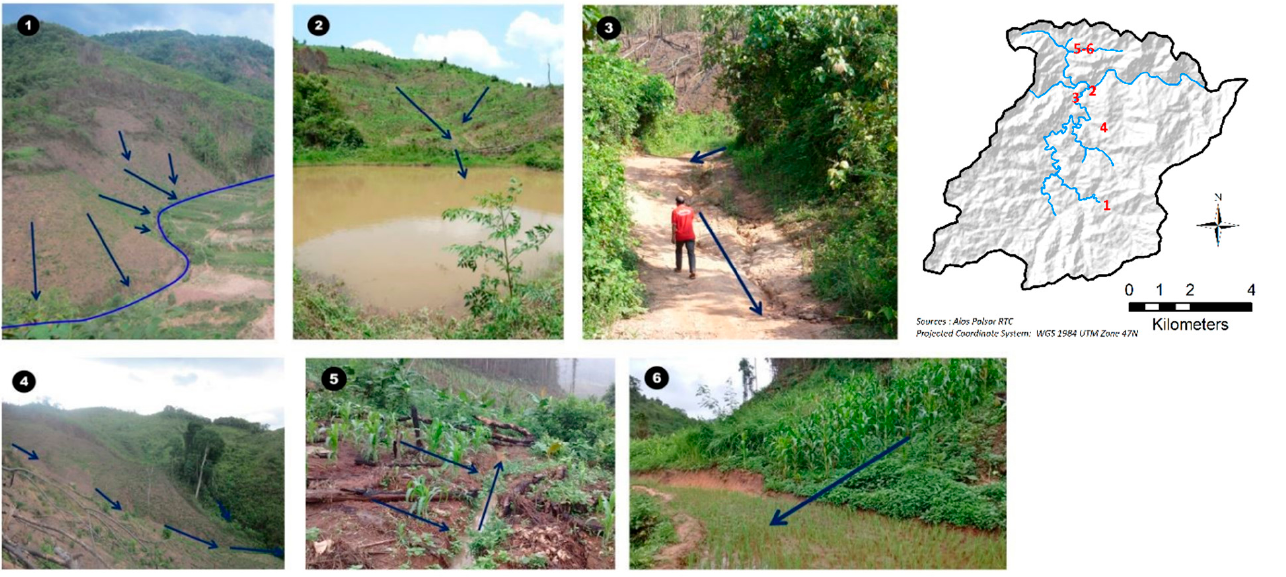
Figure 7. Example of the structural connectivity (blue arrows) with various connection types: ( 1 ) direct connection from plot to river; ( 2 ) hillslope hollow to ponds; ( 3 ) rills indicating a connection from a dirt road to the background upland plot; ( 4 ) gully connection in a steep upland; ( 5 ) irrigation ditch connection; ( 6 ) direct connection from upland grown with maize and a paddy field recently planted.